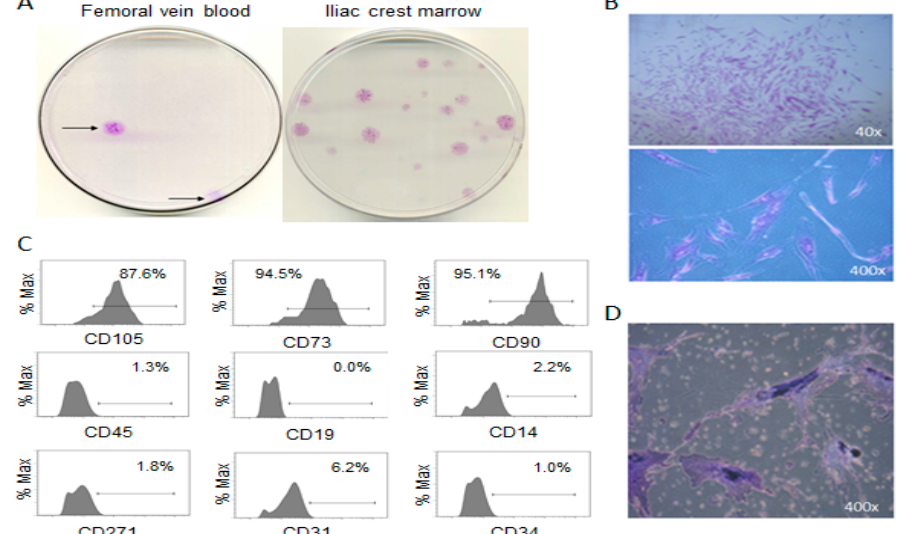
Figure 1. Identification and phenotype of putative MSC colonies. ( A ) Macroscopic image of fibroblast- like colonies isolated from femoral vein blood (FVB) compared to iliac crest bone marrow, B ) microscopic images of FVB colonies, C ) histograms from flow cytometry of plastic adherent culture- expanded cells isolated from FVB D ) alkaline phosphatase staining of putative MSCs following osteogenic induction.